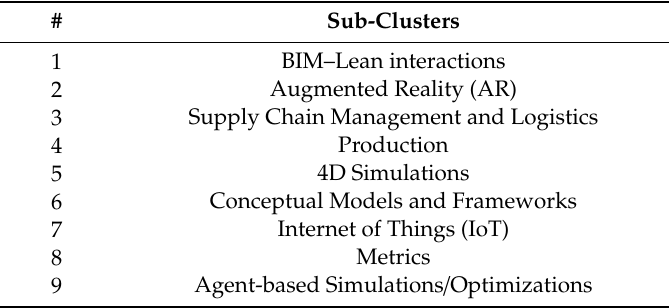
Table 5. Sub-clusters after second